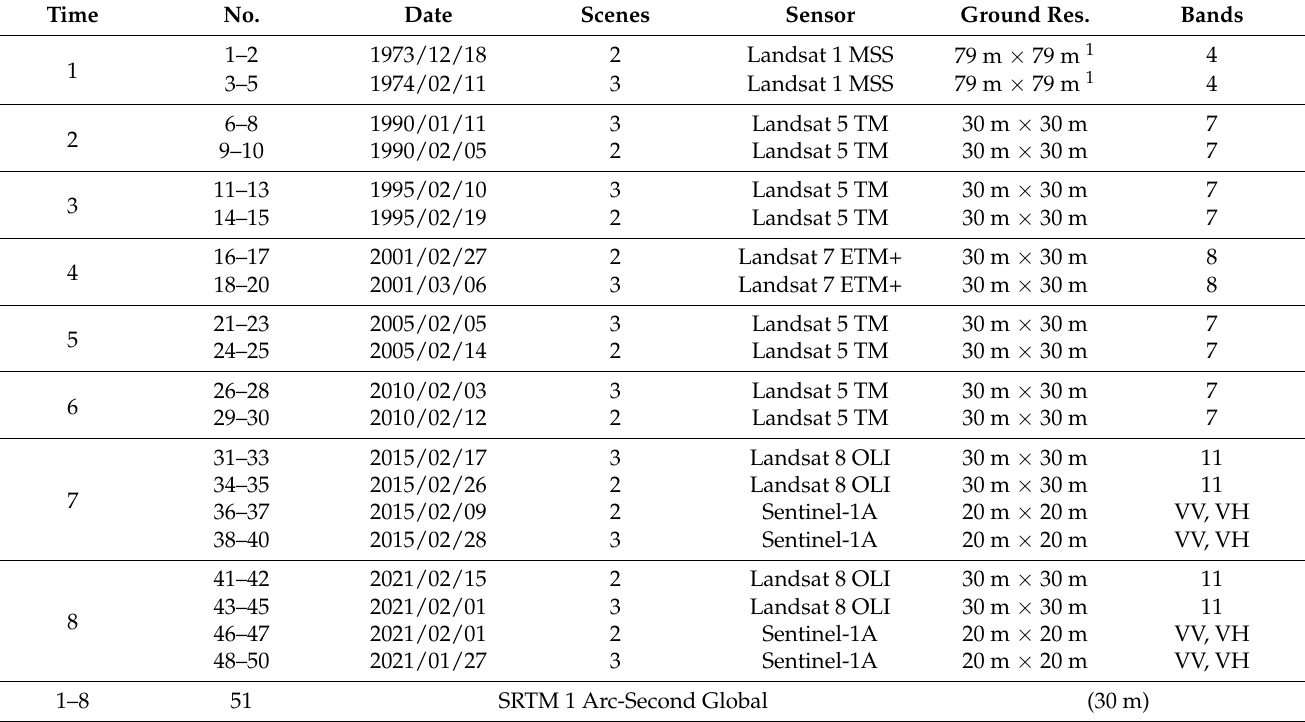
Table 1. Remote Sensing data used in this study with corresponding time